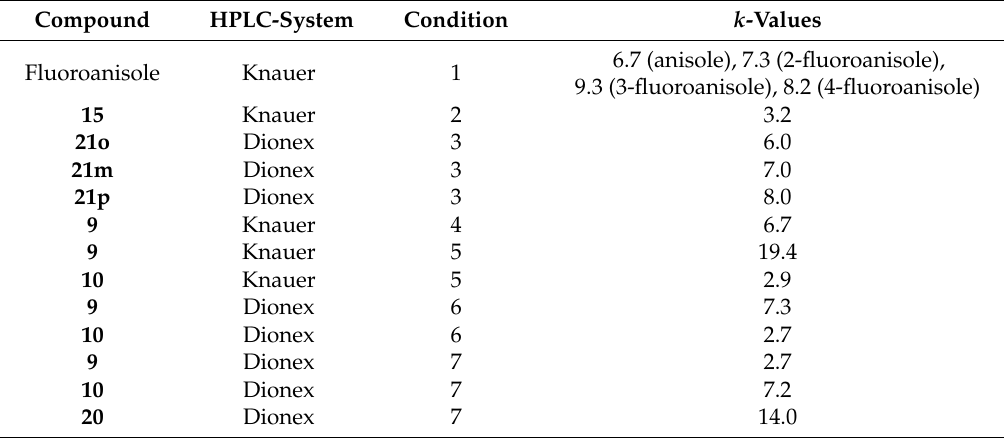
Table 2. k -Values of 19 F-reference compounds for HPLC-identification of labelled compounds. Compound HPLC-System Condition k -Values